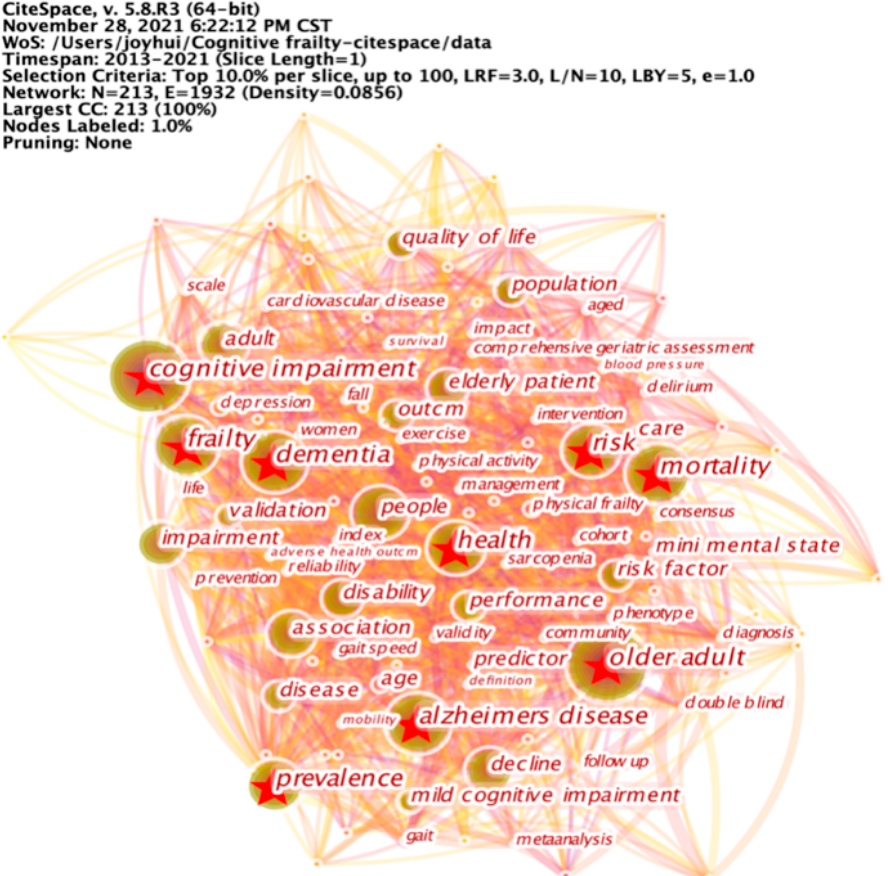
Figure 6. Network of co-occurring keywords. The most frequently occurring keyword in cognitive frailty research was “older adult”, followed by “cognitive impairment”, “frailty”, “risk”, “dementia”, “prevalence”, “mortality”, “health”, and “Alzheimer’s disease”. Burst keywords were detected, to analyze the hotspots and frontier of cognitive frailty research. We identified the top 20 keywords with the strongest citation burst (Figure 7). Of them, “disability” showed the highest burst strength, reaching 9.61. “Cognitive frailty”, “dysfunction”, “model”, and “American college” were keywords with recent citation bursts, and “randomized controlled trial” achieved the longest burst duration from 2013 to